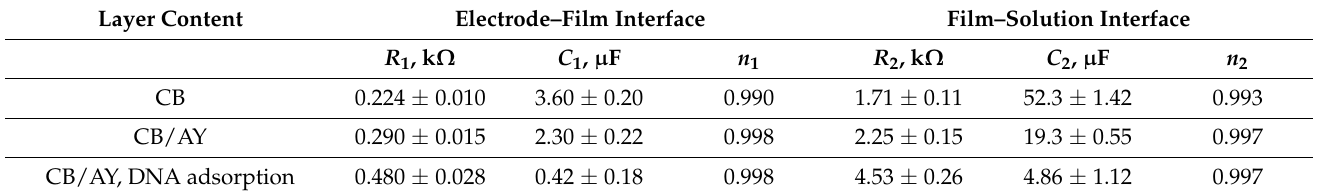
Figure 6. The Nyquist diagrams of the impedance spectra recorded on the GCE covered with CB (1), CB/AY (2) and that after adsorption of DNA (3). Frequency range from 0.04 Hz to 100 kHz, amplitude of the applied sine potential 5 mV, 0.025 M phosphate buffer, pH = 4.0. Inset: equivalent circuit applied for the data fitting. R is the charge transfer resistance and C constant phase element Rs is the electrolyte resistance. Index 1 corresponds to the solution–layer interface and index 2 to the electrode–layer interface. Table 1. EIS parameters corresponded to various steps of the surface layer assembling (average ± S.D. for five electrodes). Layer Content